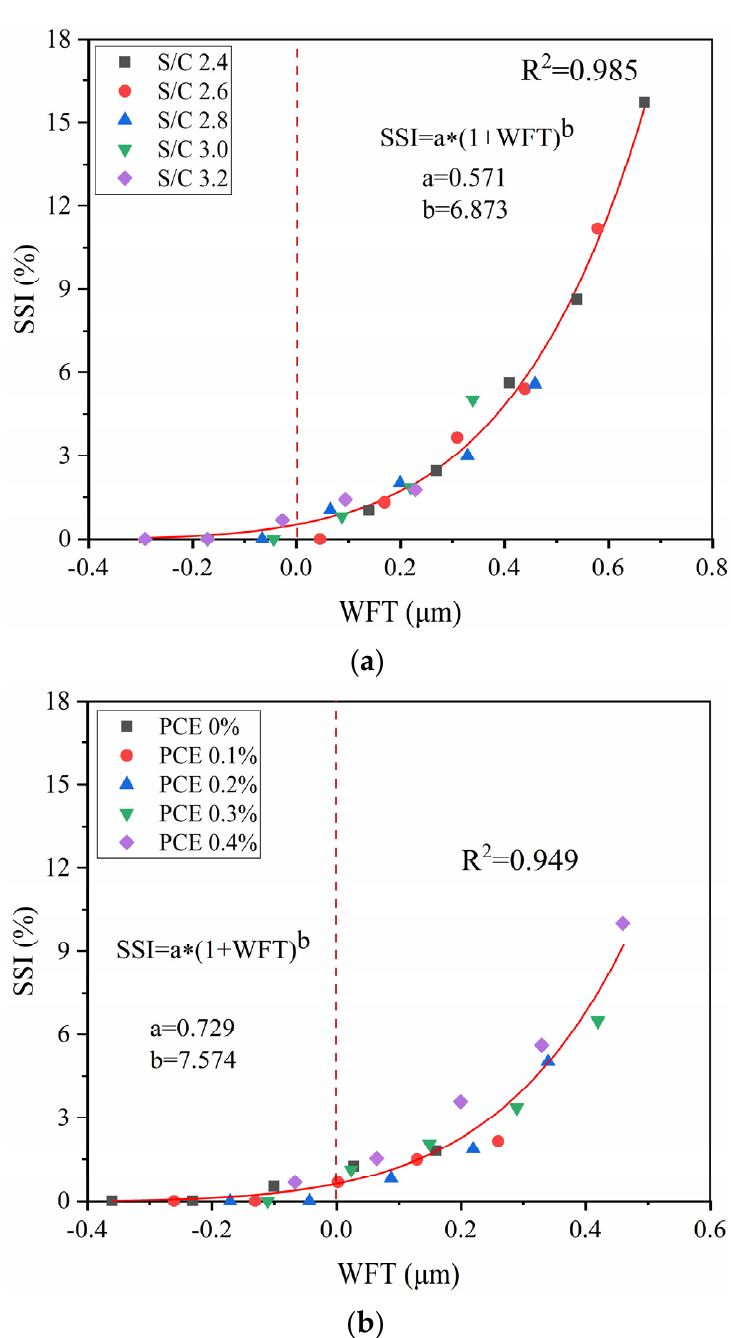
Figure 9. SSI versus WFT: ( a ) different S/C ratios, ( b ) different PCE dosages.